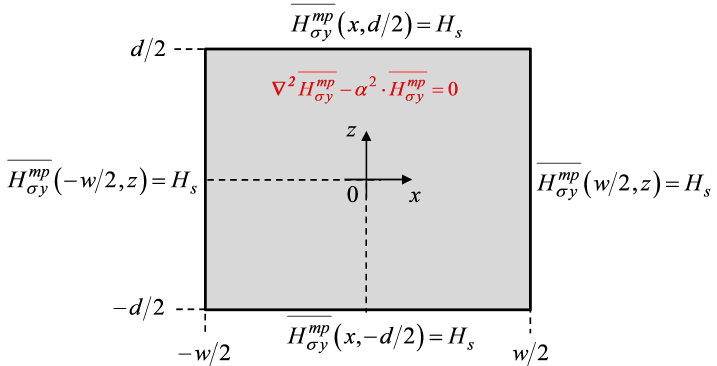
Figure 16. BCs at edges of PMs in ( x , z ) coordinate